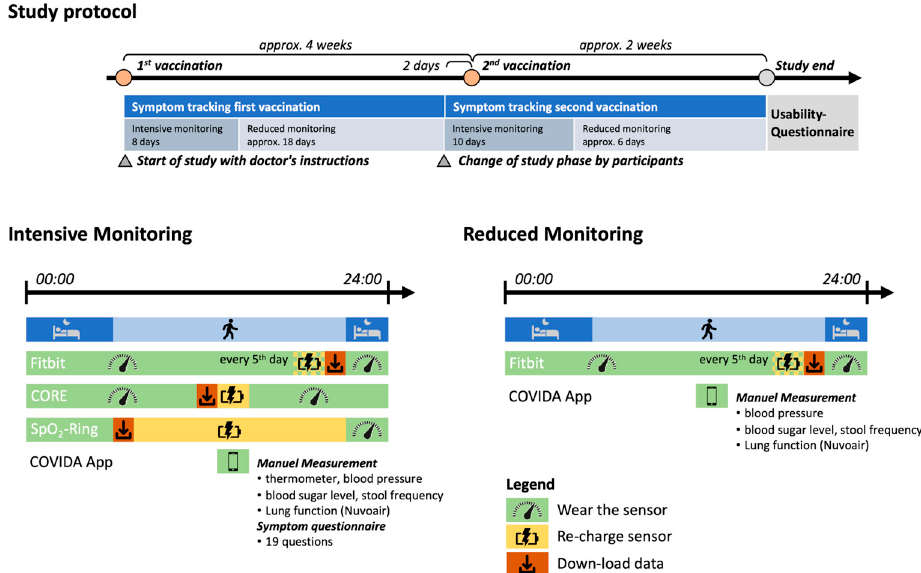
Figure 1. Daily measurement schedule during the intensive monitoring and reduced monitoring study periods. This figure was used to explain the study procedures to the patients and handed out as instructions for later reference (translated version since original was in German).